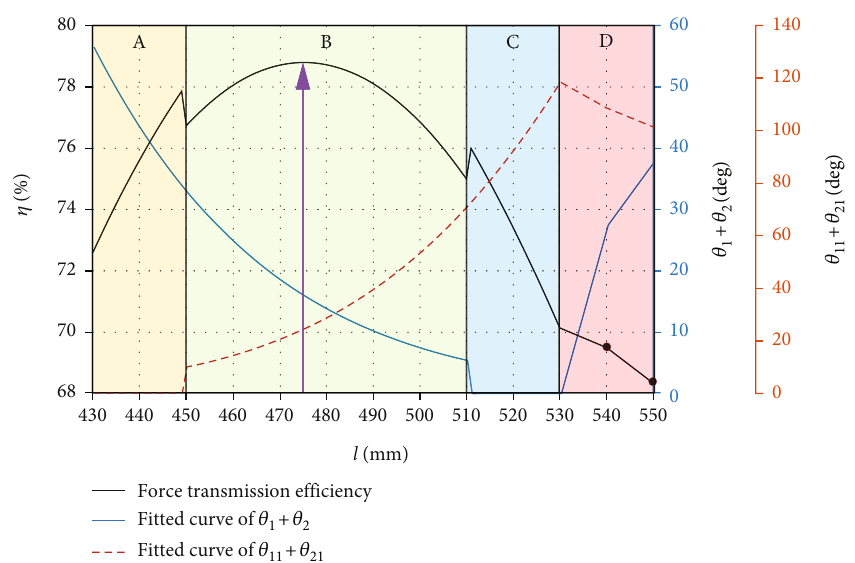
Figure 9: The relationship between η and variation of Bowden